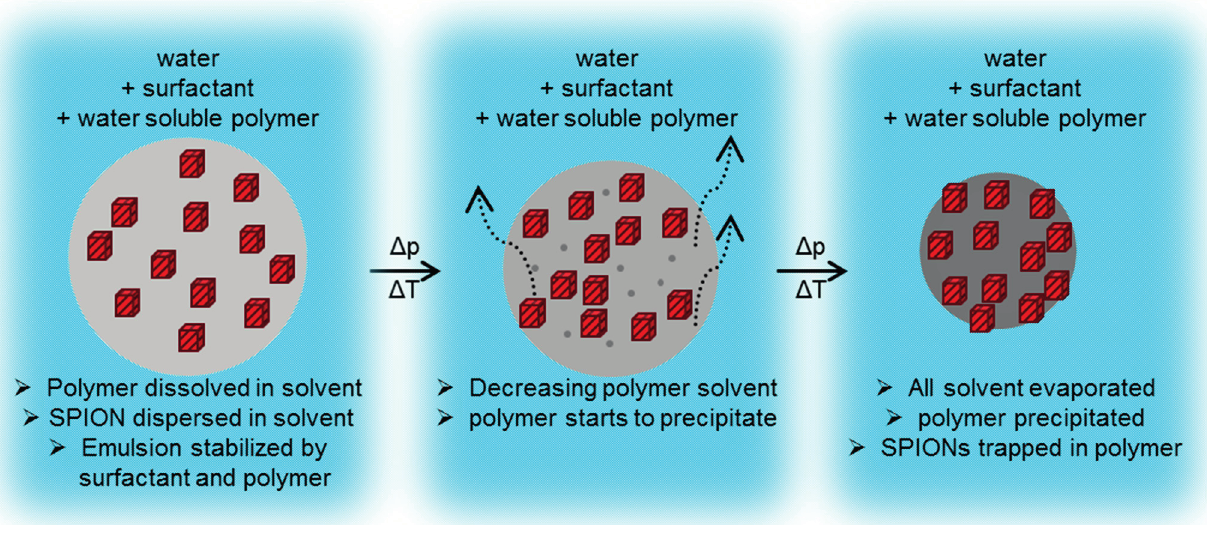
Figure 11. Schematic formation of SPION/polymer hybrid particle, starting from an oil in water emulsion droplet ( left ), proceeding with a high polymer concentration droplet ( middle ) and the formation of a solid polymer sphere with trapped SPIONs ( right